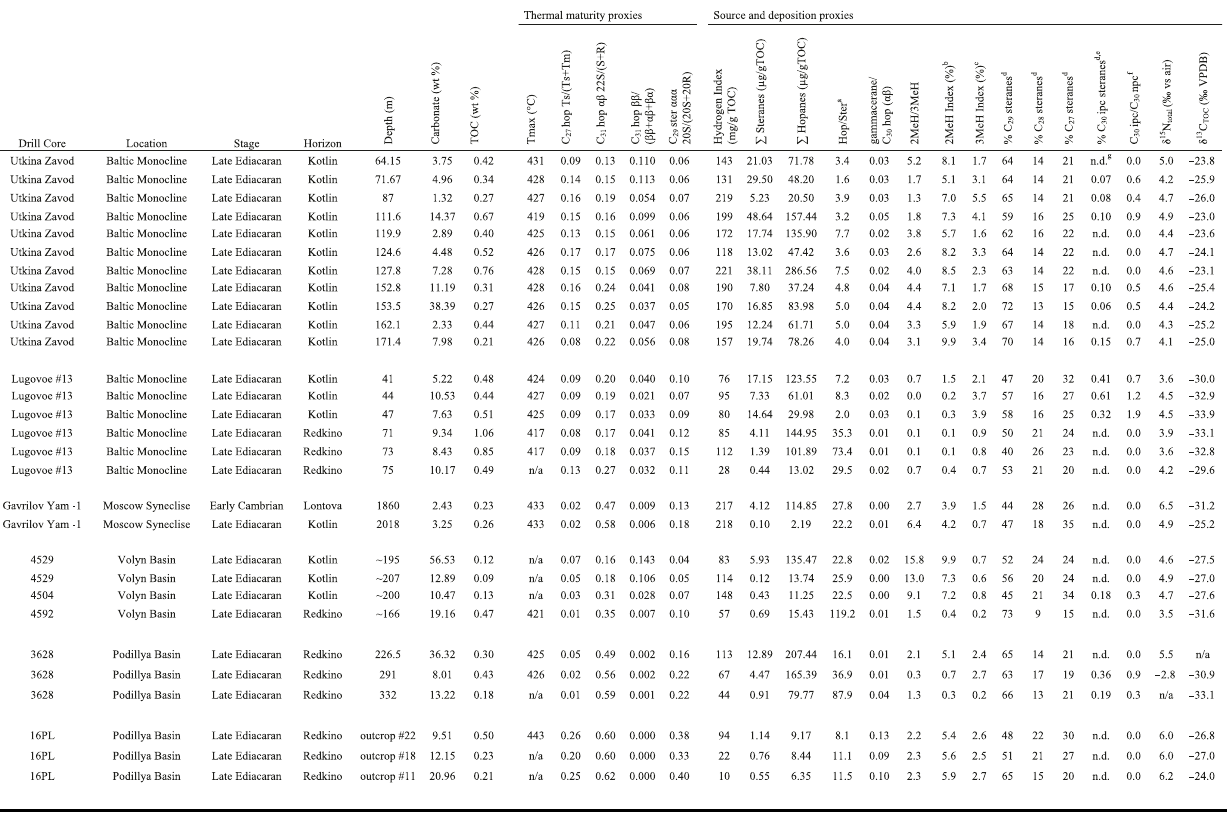
a Hop/Ster is the ratio of major (C 27 – C 35 hopane isomers)/(C 27 – C 30 diasteranes and regular steranes) b C 31 2-methylhopane index (2-MeH index) calculated as [(C 31 2 α -methylhopane + C 31 2 β -methylhopane)/(C 31 2 α -methylhopane + C 31 2 β -methylhopane + C 30 αβ hopane)*100] c C